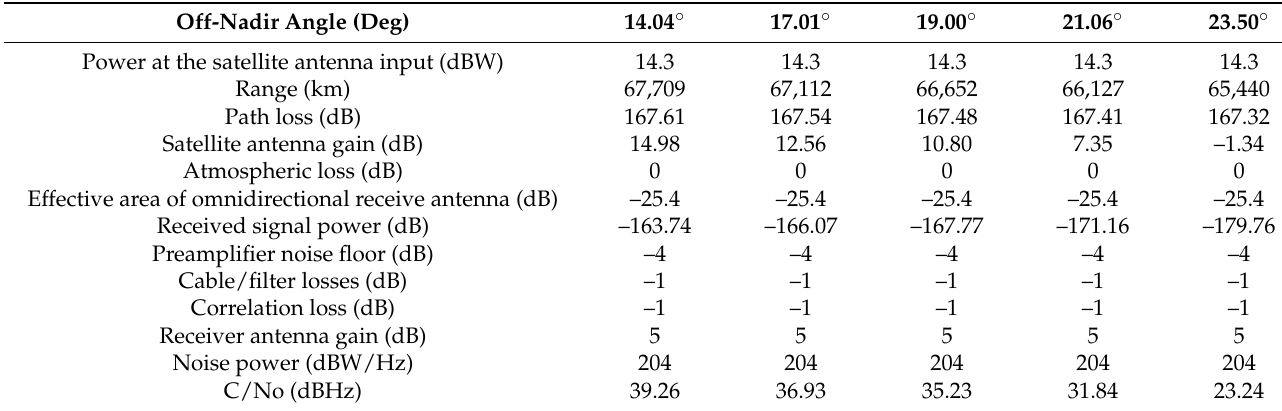
Table A1. Link-budget analysis summary of GEO